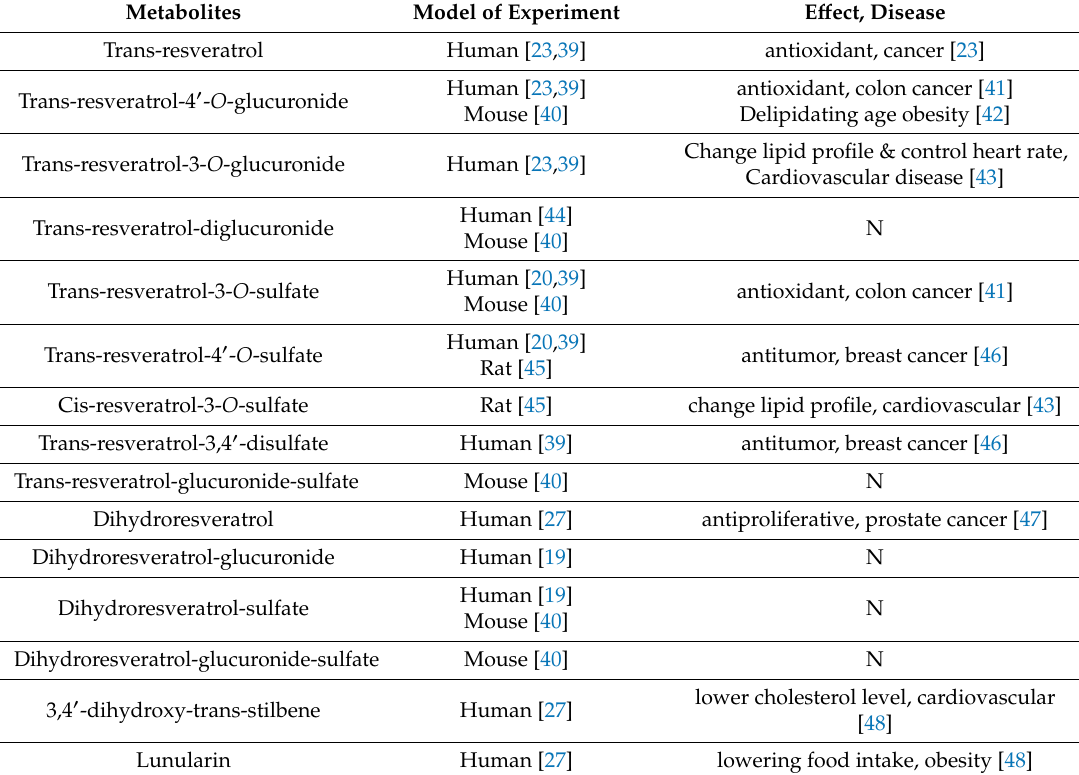
Table 1. Resveratrol metabolites and its pharmacological activities. (N = No reported